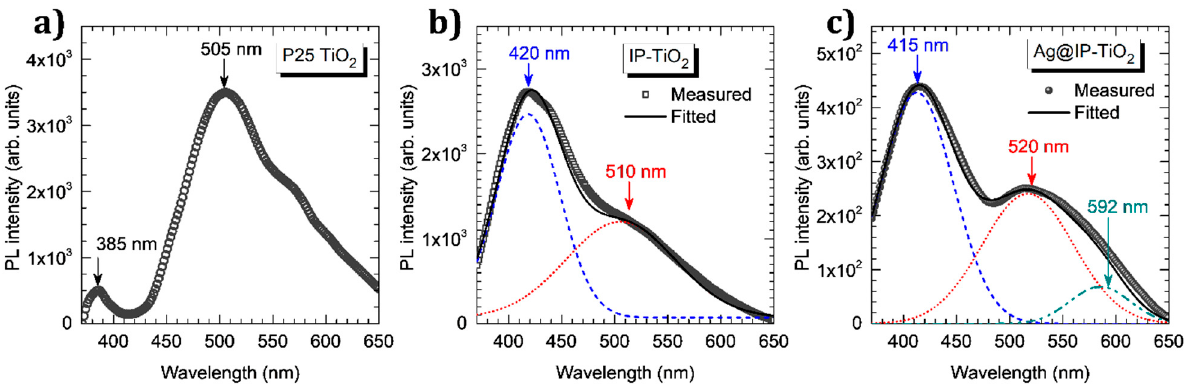
Figure 4. PL spectra of ( a ) P25 TiO 2 , ( b ) IP-TiO 2 , and ( c ) Ag@IP-TiO 2 .